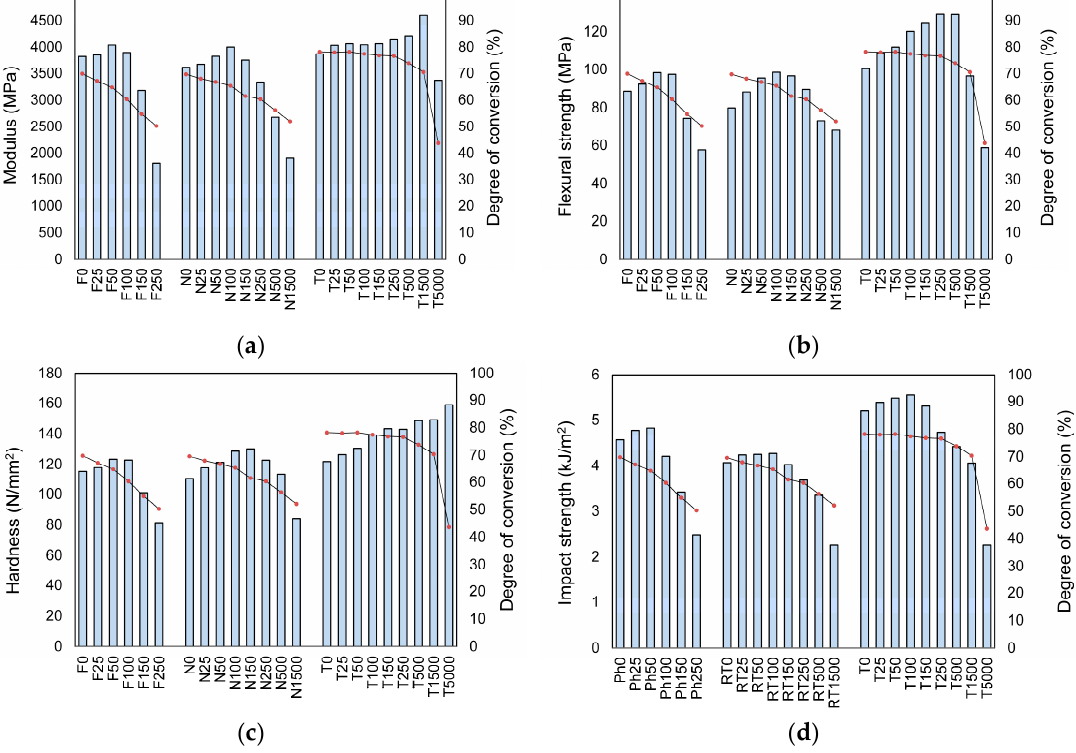
Figure 4. The comparison of mechanical properties with the degree of conversion: ( a ) modulus; ( b ) flexural strength; ( c ) hardness; ( d ) impact resistance. Bar charts correspond to mechanical properties, whereas line charts correspond to the DC .